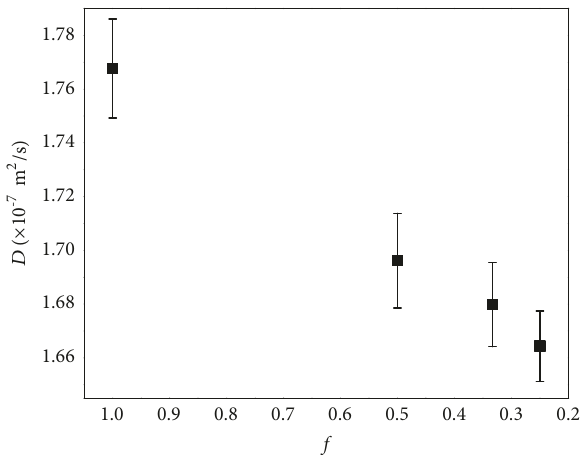
Figure 10: Normalized diffusivity of the diluted (𝑓 < 1) and stock (𝑓 = 1) colloids.